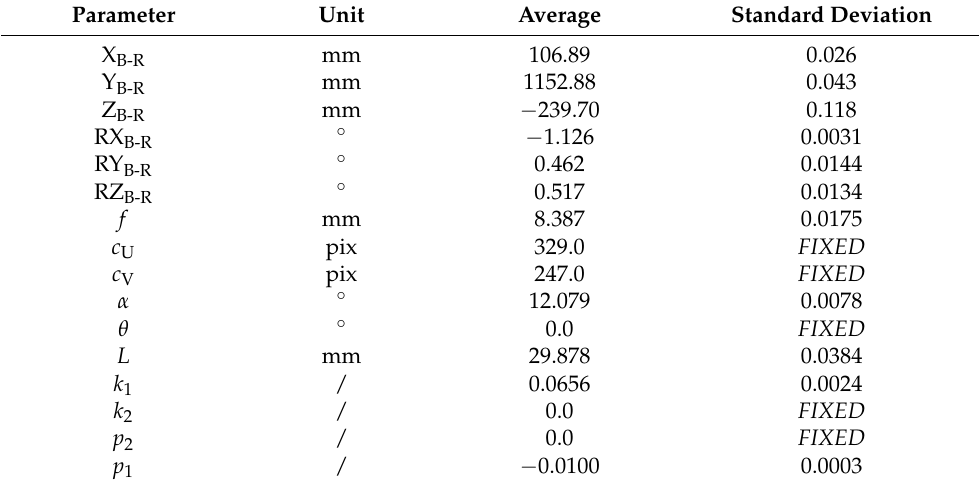
Table 2. Average values of optimized transformation parameters and respective standard deviations for N = 5 repeated calibrations where the hand–eye configuration was randomly varied. Parameter Unit Average Standard Deviation X B-R mm 106.89